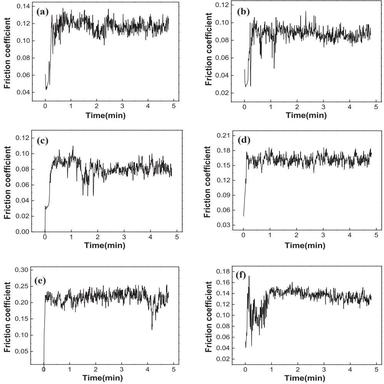
The curve of friction coefficient-time: (a) 100% 316L + 0% Inconel625; (b) 80% 316L + 20% Inconel625; (c) 60% 316L + 40% Inconel625; (d) 40% 316L + 60% Inconel625;(e)20%316L + 80%Inconel625; (f) 0% 316L + 100% Inconel625.